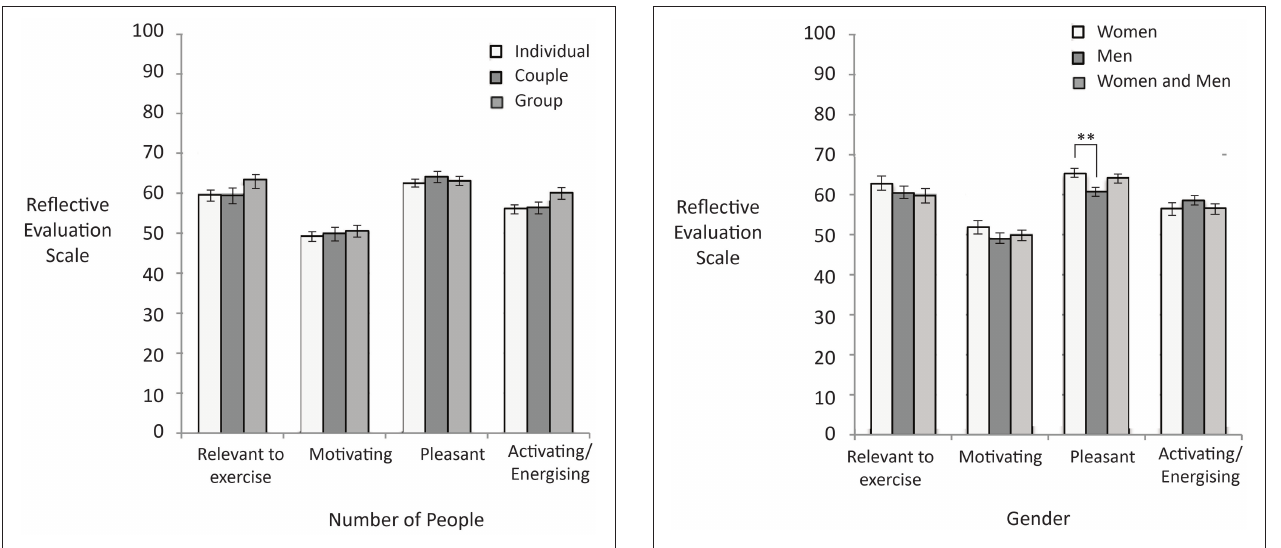
FIGURE 4 | Higher scores represent higher reflective evaluation ratings on the 0–100 response scale. There were no significant differences. Error bars reflect standard errors.